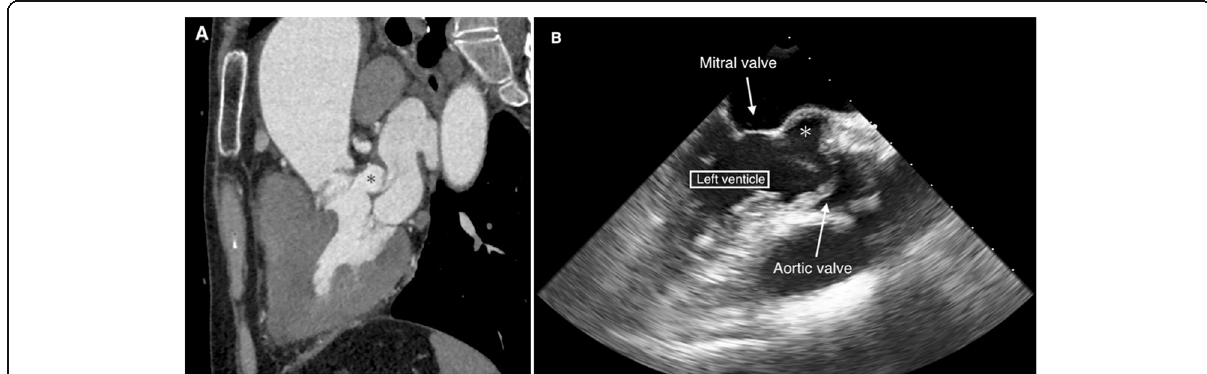
Fig. 1 Preoperative computed tomography and echocardiography. Preoperative computed tomography ( A ) showing the cavity (asterisk) at the left ventricle outflow tract between the noncoronary cusp of the aortic valve and anterior leaflet of the mitral valve. Preoperative echocardiography ( B ) also showing the cavity (asterisk) at the same position. This was a pseudoaneurysm of the mitral-aortic intervalvular